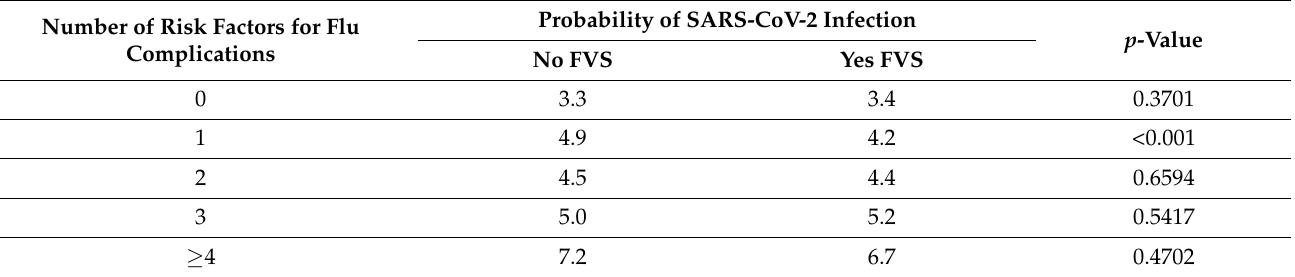
Table 4. Percentage of people contracting COVID-19, depending on the number of risk factors for flu complications, according to whether they had been vaccinated against flu (FVS).